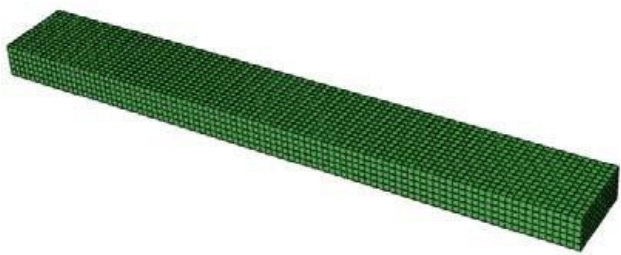
Figure 4. Model of the specimen for the numerical bending test.